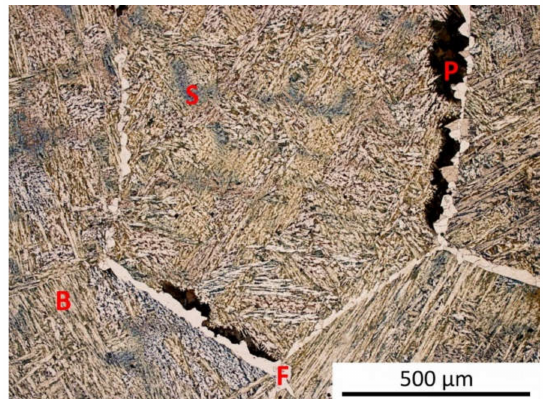
Figure 1. Microstructure of the investigated steel with bainite ( B ), ferrite ( F ) and perlite ( P )—initial state; dendritic segregations ( S ) are grey (light microscopy).